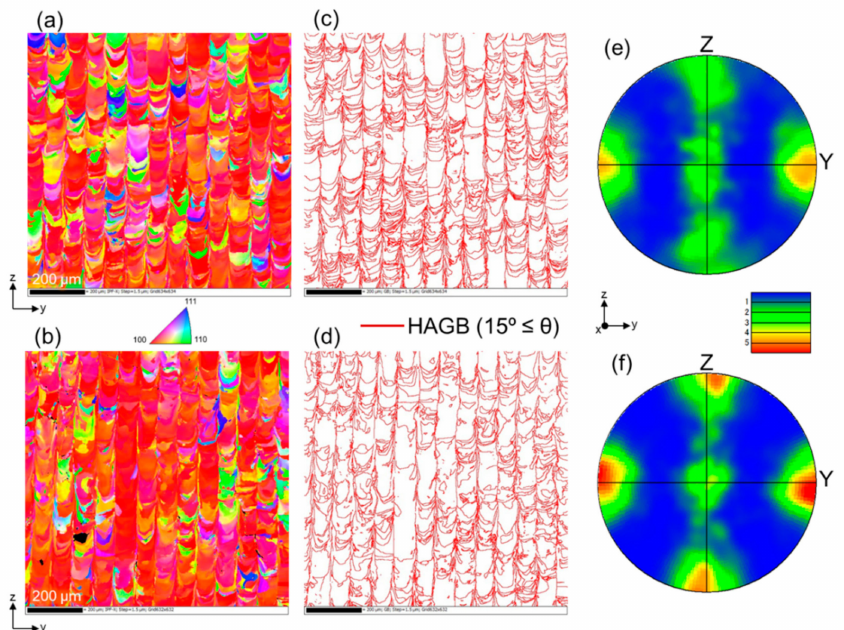
Figure 3. Electron backscatter diffraction system (EBSD) inverse pole figure (IPF) maps showing variation in the texture of as-built Cr for ( a ) long scan length and ( b ) short scan length with corresponding ( c , d ) HAGB maps and ( e , f ) {100} pole figures for the y–z plane.